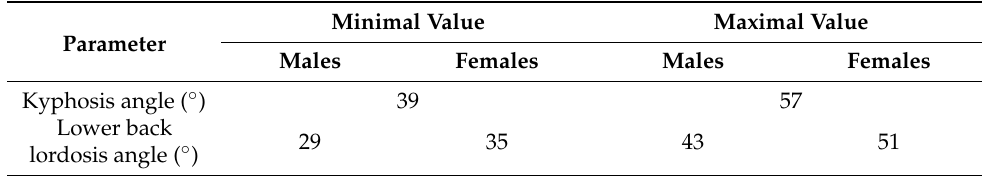
Table 2. Reference values of the angles of the kyphosis and lower back lordosis [37]. Parameter